Question: Author a descriptive caption for the visualization shown.
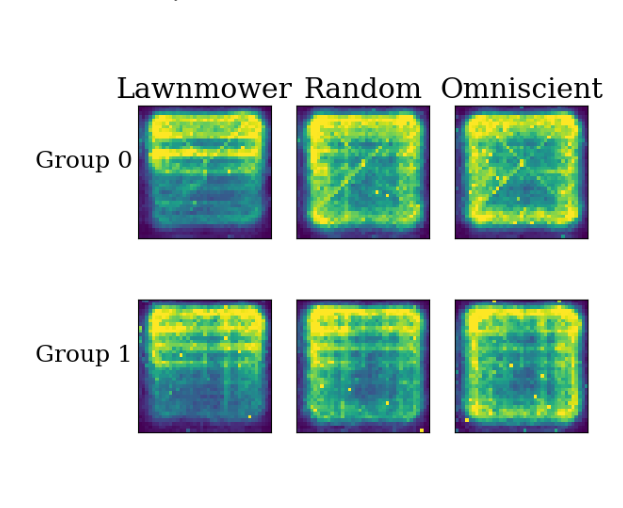
Answer: A heatmap of the subject searched area with the initial position removed. The Lawnmower strategy was more predictable and resulted in subjects avoiding the autonomous searcher’s area. The Random and Omniscient strategies were more likely to search the center areas, resulting in subjects searching the exterior of the grid more often.